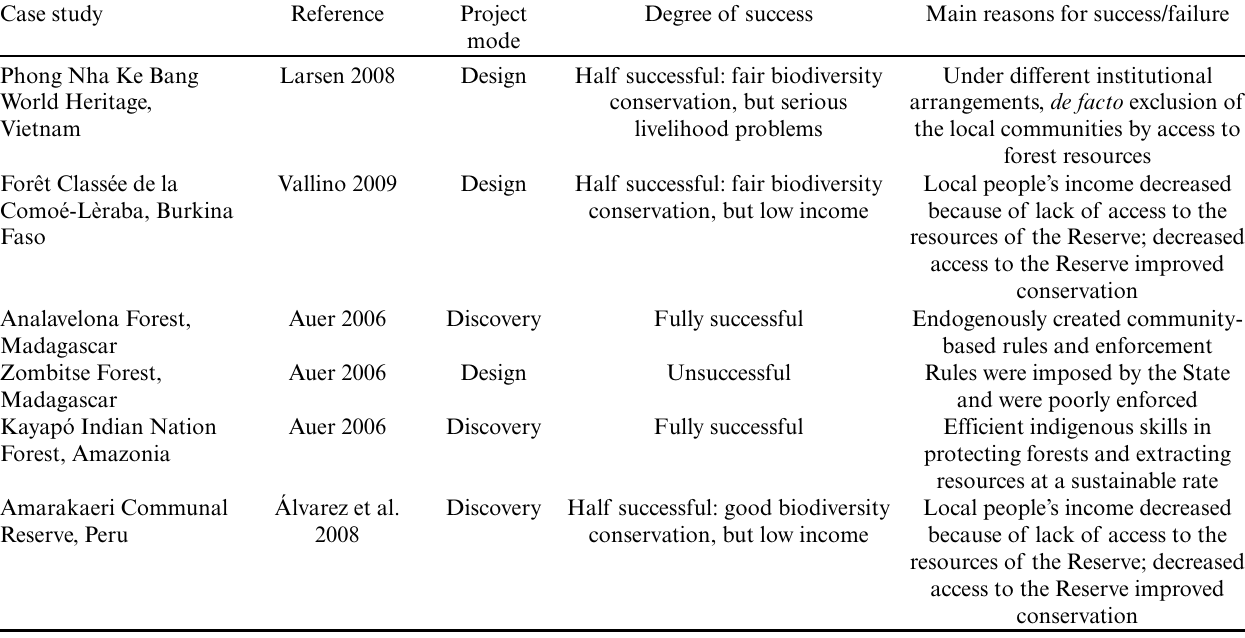
Table 1. Selected case studies of participatory forest management experiences in different countries, with information about their design or discovery mode and their degree of success. “Successful” refers to the achievement of two goals: the resource to be protected is allowed to renew itself at a sustainable rate, and the community improves its standard of living, measured mainly in monetary terms, through the participatory conservation